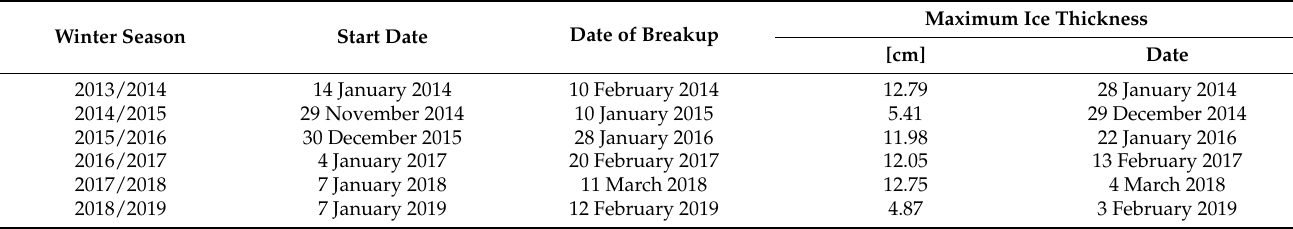
Figure 4. Calculated thickness of the ice cover on the Ł apino reservoir in 2013-2019 based on the sum of negative temper- atures from the Ś wibno station in the winter season ( a ) 2013/2016; ( b ) 2014/2015, ( c ) 2015/2016 ( d ) 2017/2018.